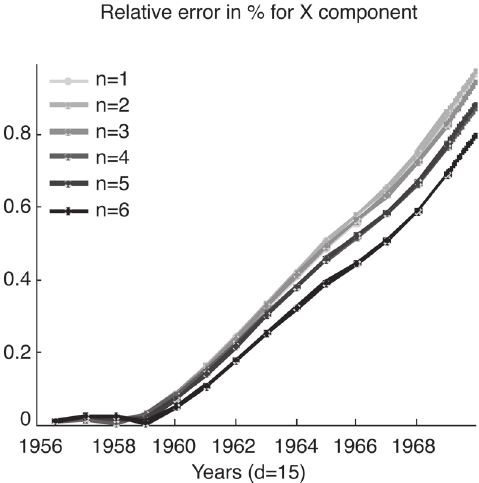
Fig. 4. Variation of relative error of prediction by the prediction year, for different number n of neurons per layer.